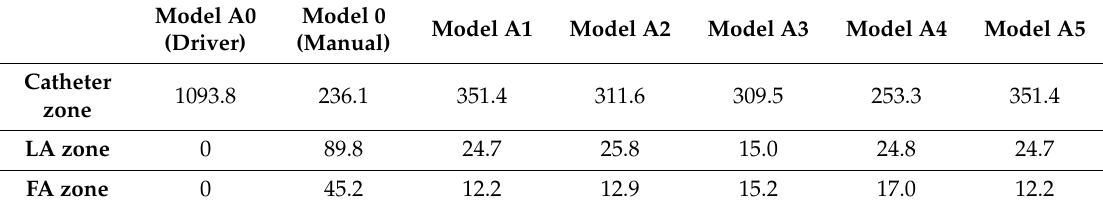
Table 3. Gradient of mass fraction of the anticancer agent in the catheter zone, LA zone, and FA zone in models A0–A5.